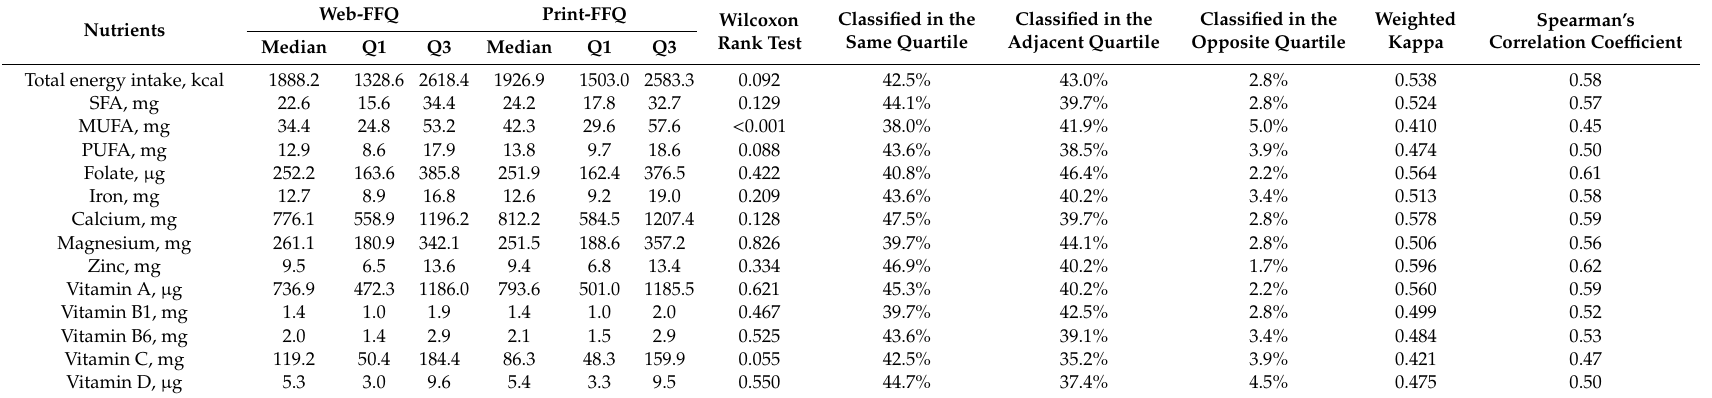
Table 2. Daily nutrient intakes, Spearman’s correlation coe ffi cients and quartile misclassification analysis between the web-FFQ and